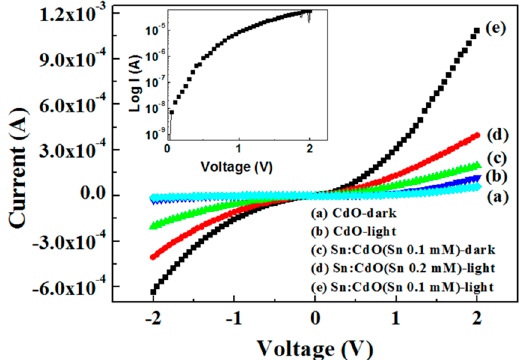
Figure 13. Photoresponse analyses of n-CdO/p-Si heterostructures under dark and illuminated conditions. The inset shows the semi-log plot of the dark I-V response.